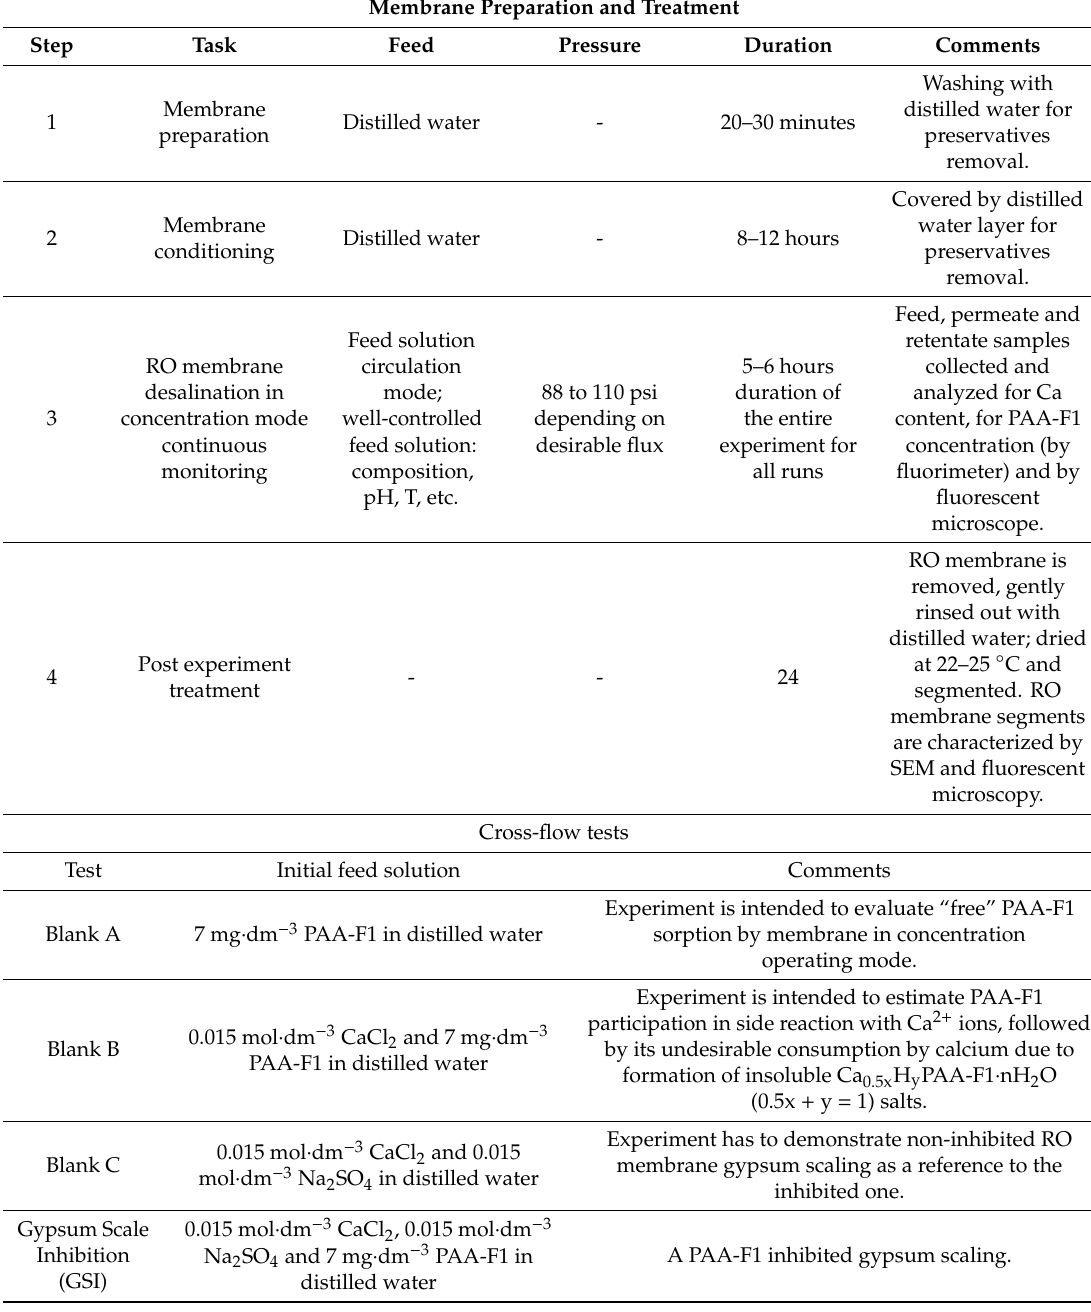
Table 2. Experimental protocol for the scaling tests in cross-flow RO membrane